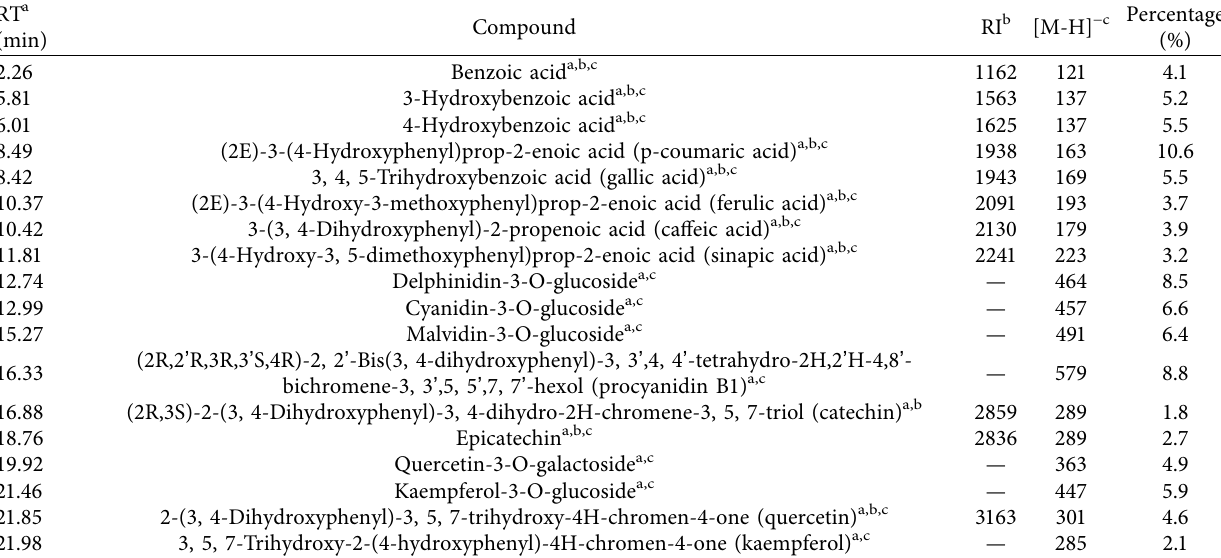
Table 4: LC-MS analysis results of the aqueous grape pomace extract.